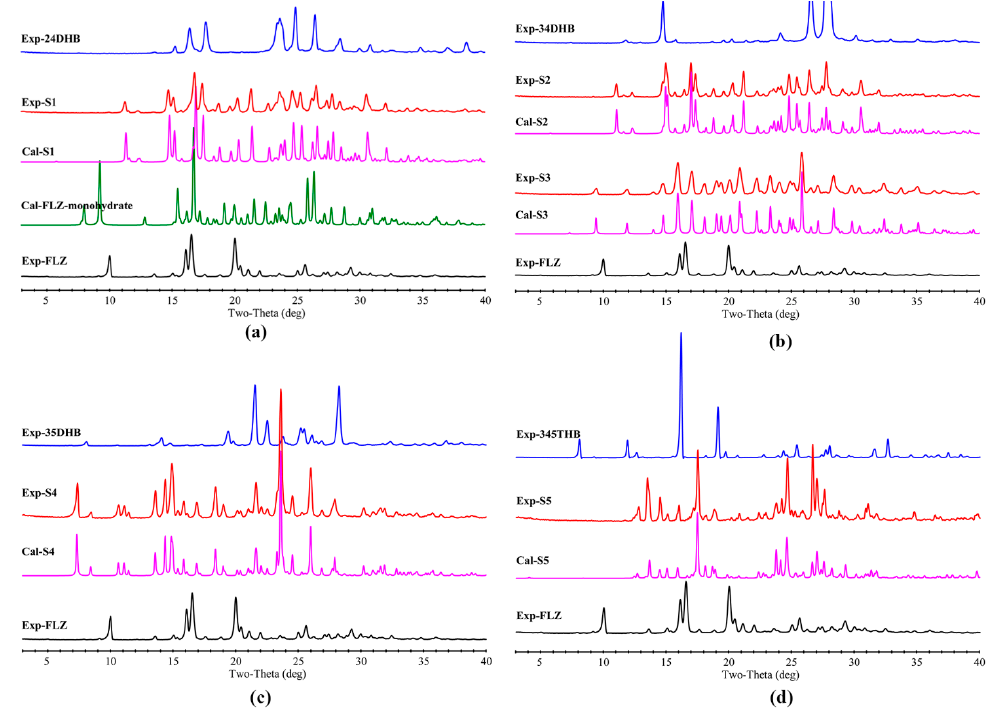
Figure 8. Comparison of experimental FLZ used in this study, simulated FLZ monohydrate, and the experimental and simulated PXRD patterns of ( a ) FLZ − 24DHB − H 2 O (1:0.5:1, S1), ( b